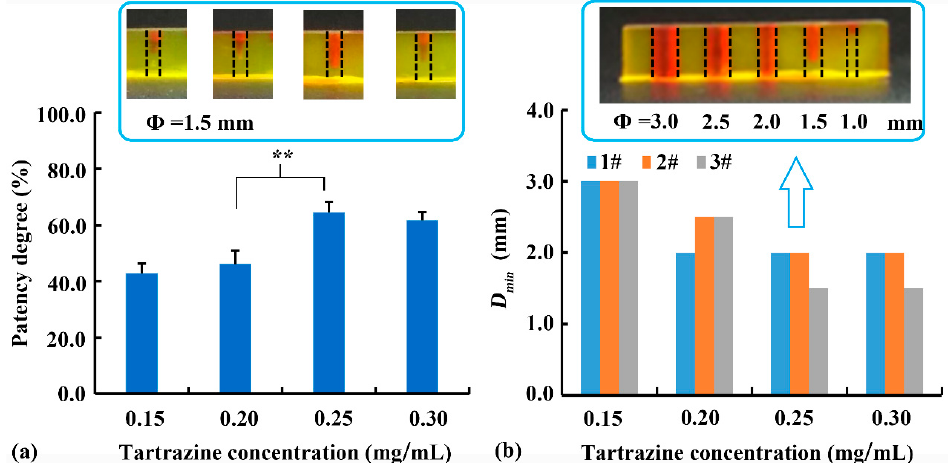
Figure 4. Effect of tartrazine concentration on ( a ) patency degree of the vertical channel with a diameter of 1.5 mm (** denote p < 0.01), and ( b ) the minimum printable diameter ( D min ) of the vertical channel with different diameters, and typical sample with 0.25% tartrazine was illustrated.